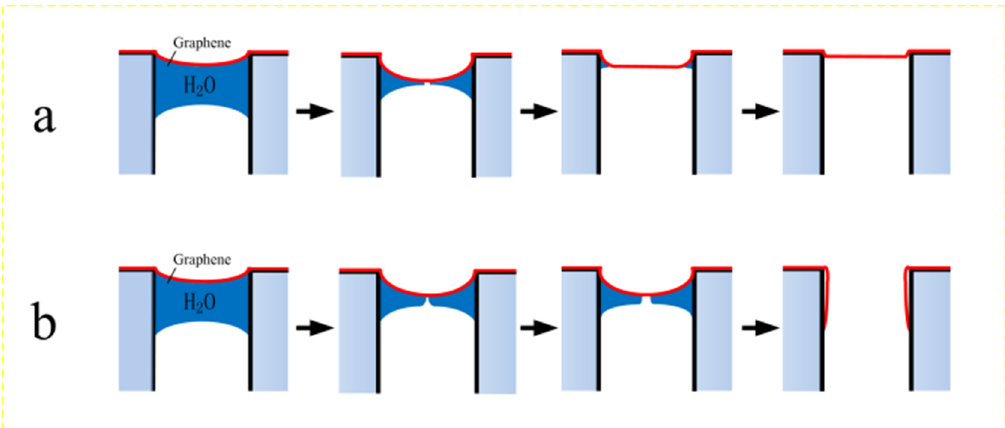
Figure 1. The schematic diagram of the suspension release process. ( a ) The process of obtaining complete suspended graphene film after drying. ( b ) The sudden stress of the solution release process causes the graphene film to rupture.